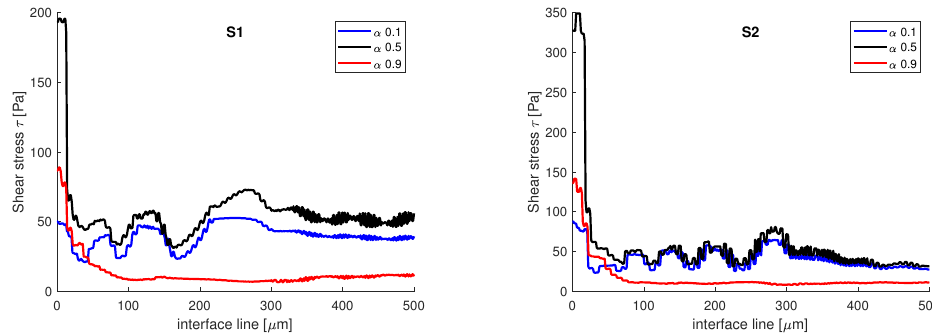
Figure 9. Shear stress variation on the interface line at different volume